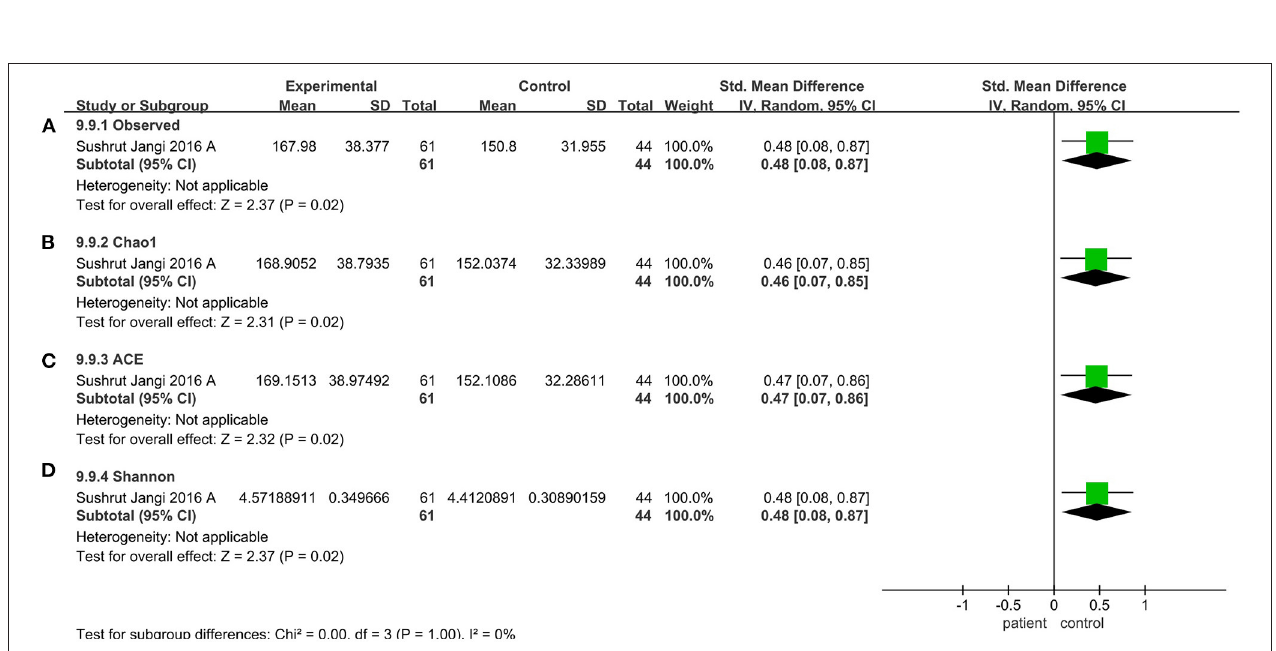
FIGURE 7 | Diversity meta-analyses for the V3-V5 sequencing region. Forest plot for the observed species (A) , Chao1 (B) , ACE (C) , and Shannon (D) . Observed, observed species; SMD, standardized mean difference; SD, standard deviation.